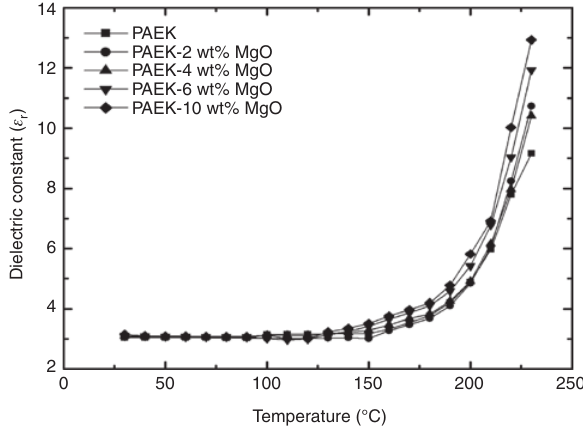
Figure 3: Effect of frequency on dielectric constant for PAEK-MgO nanocomposites.